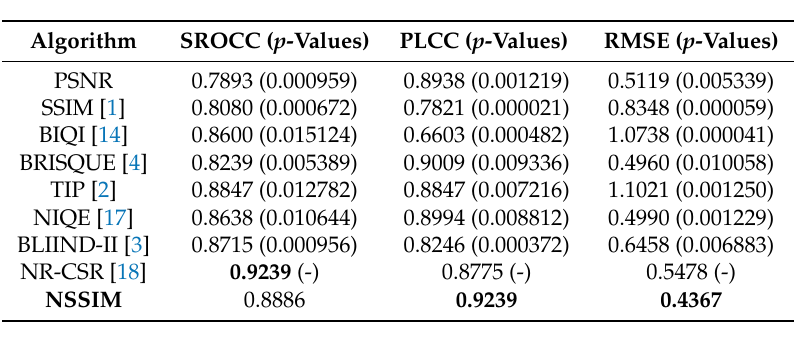
Table 8. Comparison with eight existing IQA algorithms on IVC dataset (20 Gaussian blur images). We take Spearman’s rank order correlation coefficient (SROCC), Pearson linear correlation coefficient (PLCC) and root mean square error (RMSE) as evaluation indexes. In each column, the best performance value is marked in boldface.